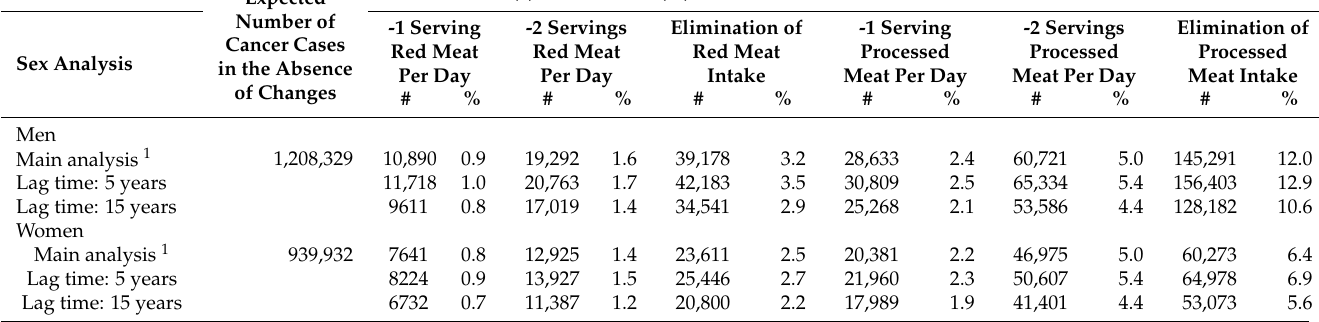
Table 2. Estimated number and proportion of colorectal cancer cases preventable under different theoretical scenarios of reducing red and processed meat intake over a 30-year period (2020–2050) in the German population, stratified by